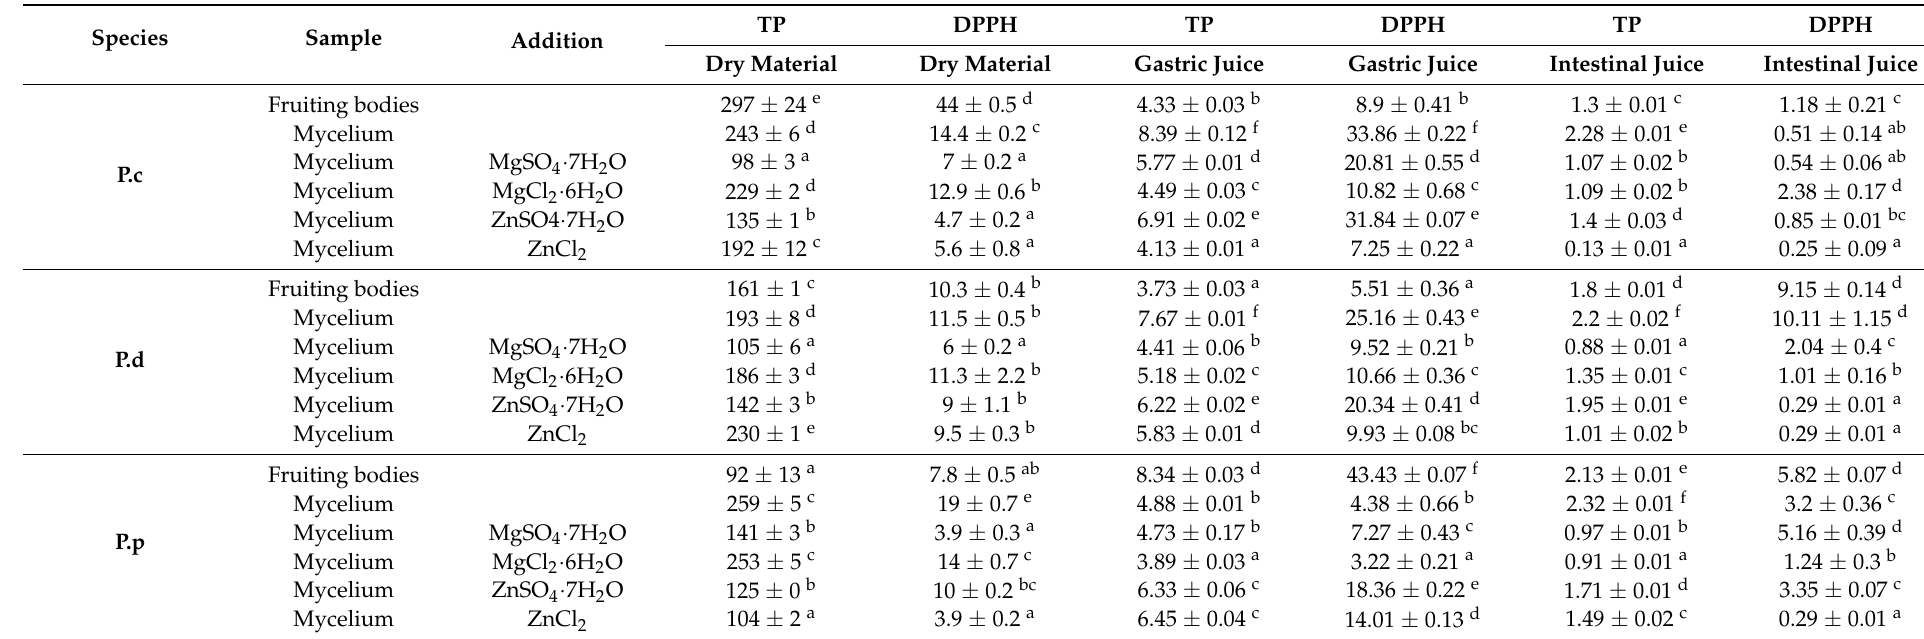
Table 5. Total phenol content and antioxidant activity (percentage of DPPH reduction) in dry material, artificial gastric juice, and artificial intestinal juice of P.c —Pleurotus citrinopileatus , P.d —Pleurotus djamor , and P.p —Pleurotus pulmonarius (mg/100